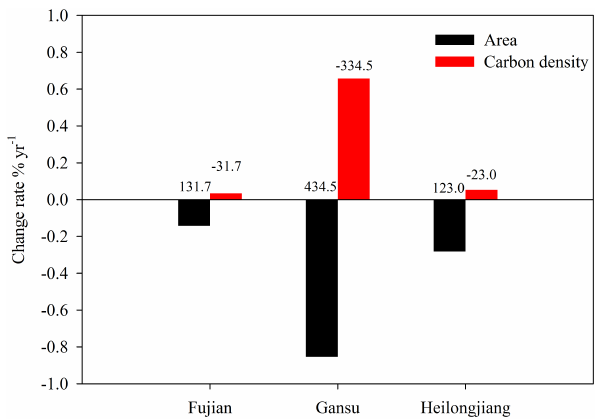
Figure 3. Rate of change and the relative contributions of changes in forest area and carbon density of natural forests to carbon loss in three provinces of China in the period 1977–2008. Bars and num- bers above represent the rates of change and the relative contribu- tions of forest area (in black) and carbon density (in red), respec- tively.